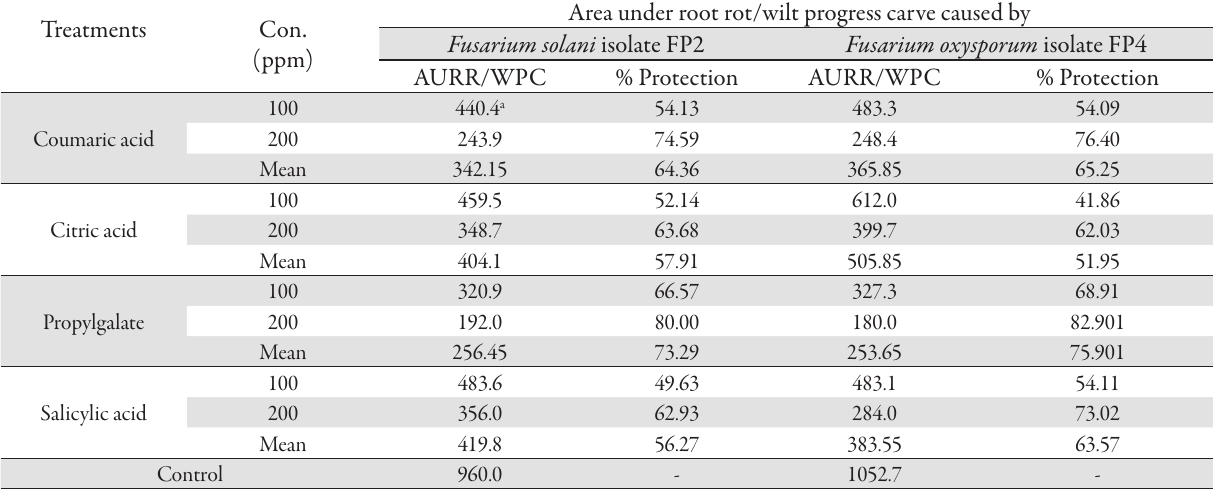
Tab. 4. Effect of soil drenching with antioxidant solutions on area under root rot/wilt progress curve caused by Fusarium solani isolate FP2 and Fusarium oxysporum isolate FP4 in pots